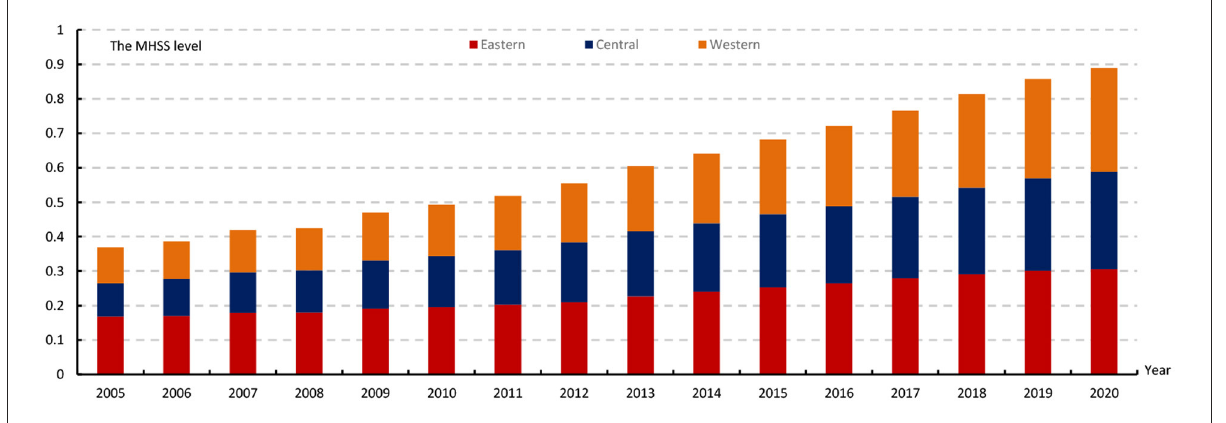
FIGURE2 The average MHSS level of three regions from 2005 to 2020.